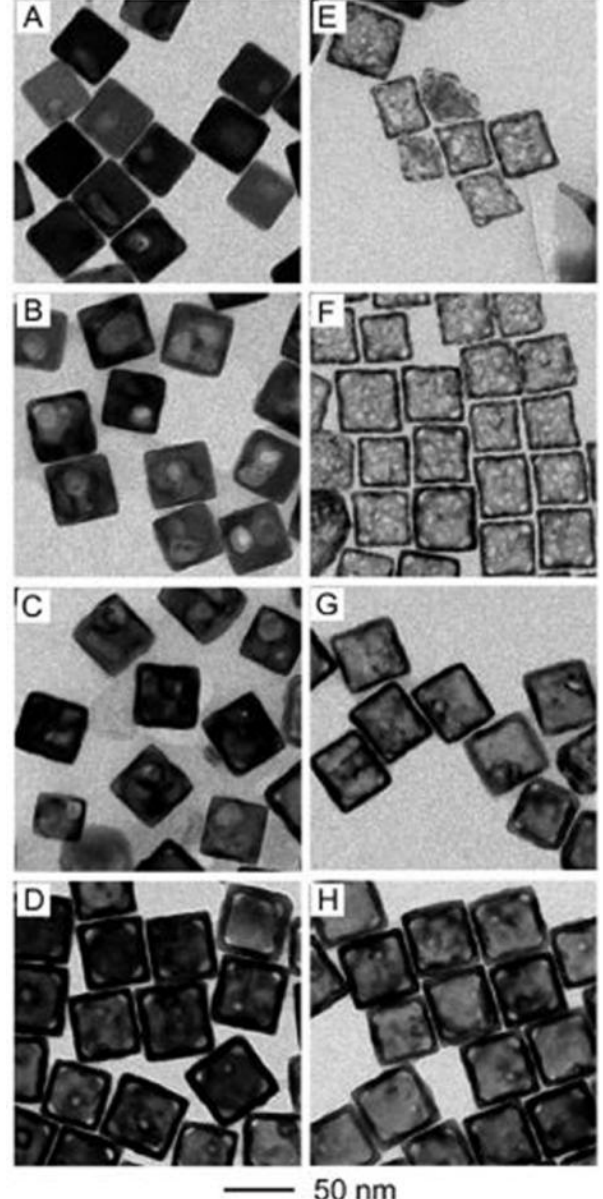
Figure 9. TEM images of Au -Ag nanoboxes before and after etching with an excess amount of H O : ( A – D ) the Au-Ag nanoboxes with their LSPR peaks being tuned to 460, 520, 675, 2 2 and 745 nm, respectively, prior to the addition of H Au-based nanocages after the addition of excess H Copyright (2010) American Chemical